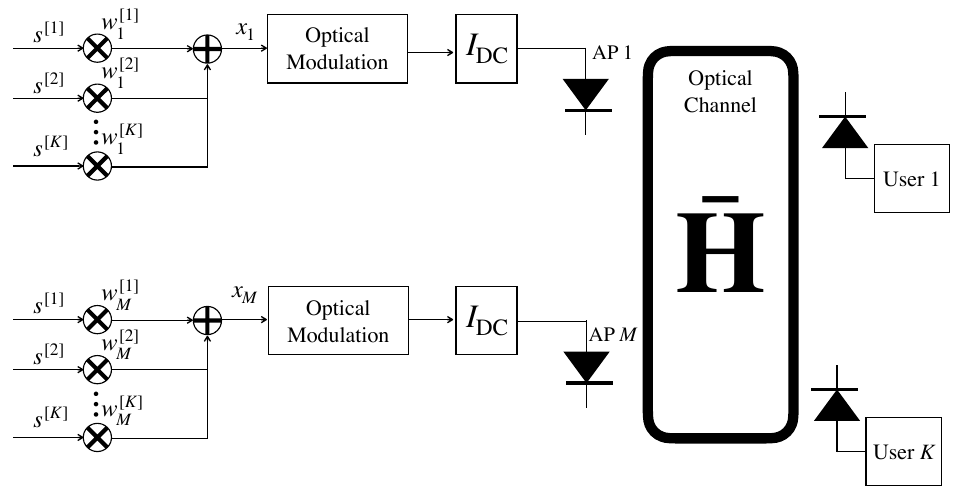
Figure 17. Schematic diagram for precoding schemes in a MU-MIMO VLC